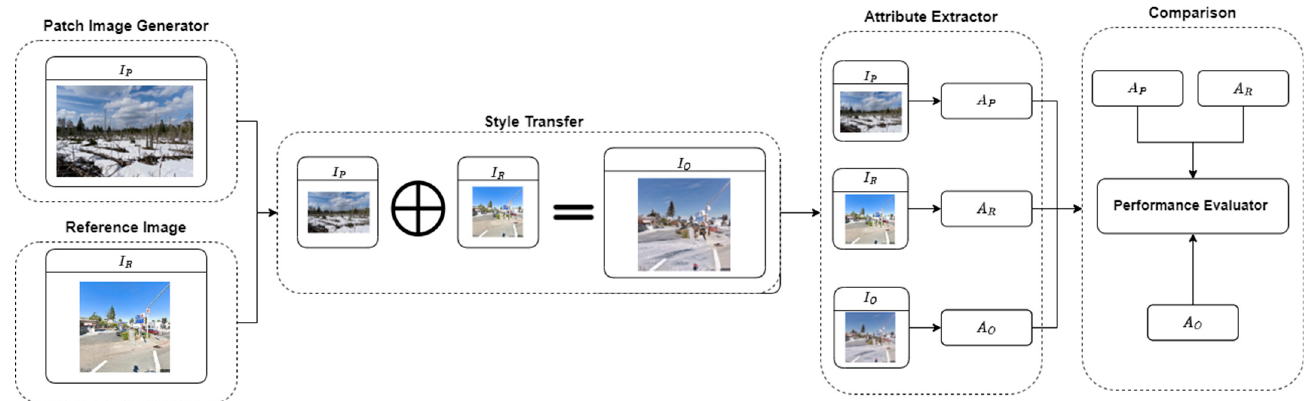
Figure 2. The overall design of the framework and a visual representation of how each component relates to the